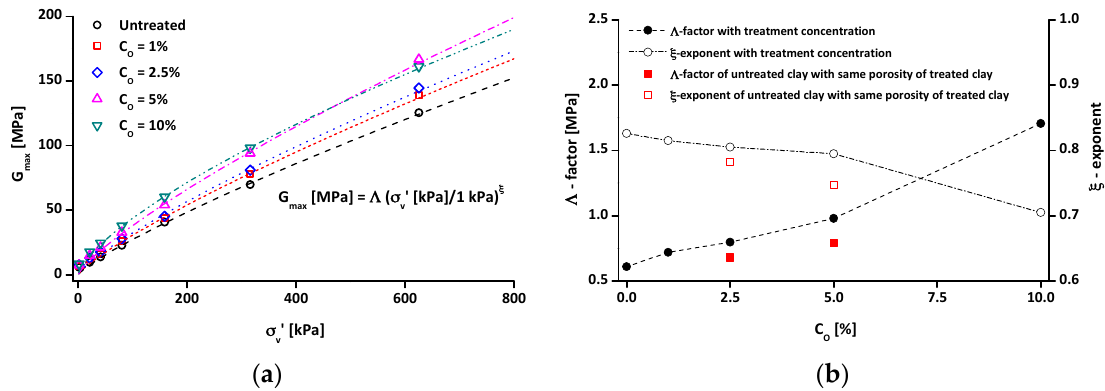
Figure 10. Small strain property of water-repellent clay: ( a ) shear modulus at small strain (G max ); and ( b ) experimental determined factor ( Λ -factor) and exponent ( ξ -exponent) of the shear modulus. Note that the rectangular symbols ( ■ and □ ) indicate the Λ -factor and ξ -exponent of untreated clay under the same initial porosities of the C O = 2.5% and C O = 5% specimens.